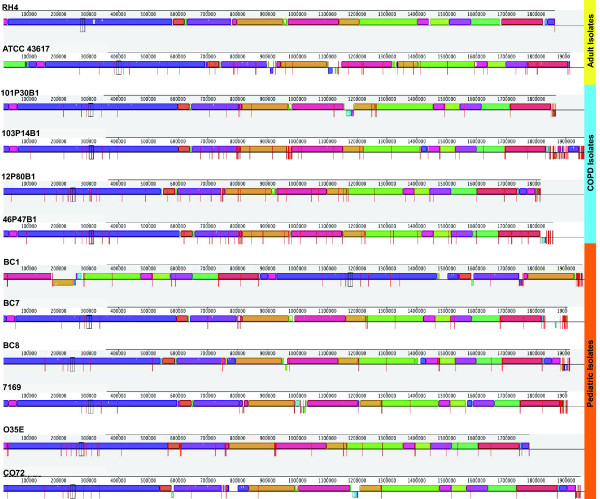
Whole genome multiple alignment of twelve isolates of M. catarrhalis. Genome sequences were categorized by patient group and each homologous LCB is identically colored in each genome. LCB's oriented above the center line for each alignment are in the same orientation as RH4, whereas LCBs oriented below the line indicates an inversion. Unconnected red lines denote contig breaks present in the eleven unfinished genomes.